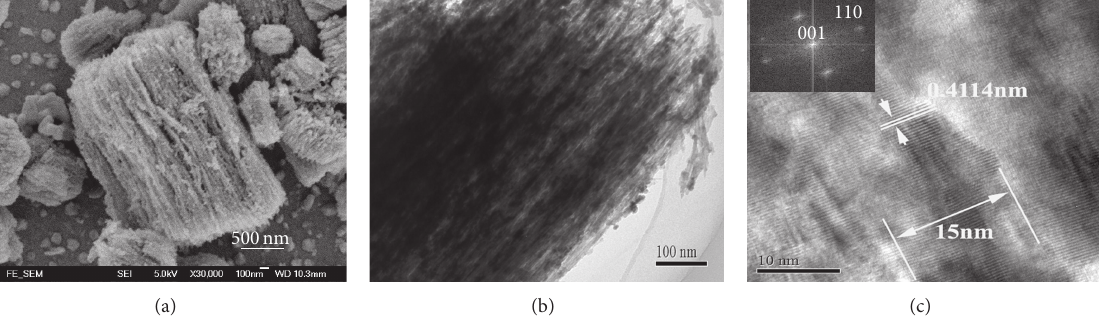
Figure 2: (a) SEM image, (b) low magnification TEM image, and (c) HRTEM image of the KNbO 3 nanowires. Inset: SAED pattern of individual nanowires.